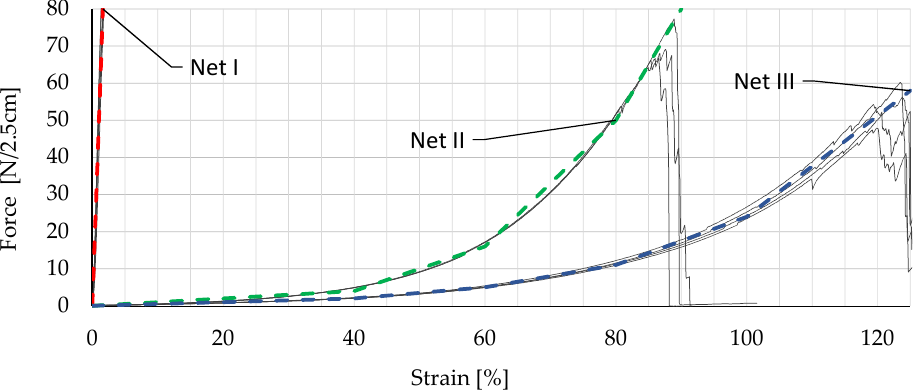
Figure 3. Tensile tests from a 2.5 cm-wide strip of the flexible material of Net I, Net II and Net III; colored lines are the mean values of the tensile test results.